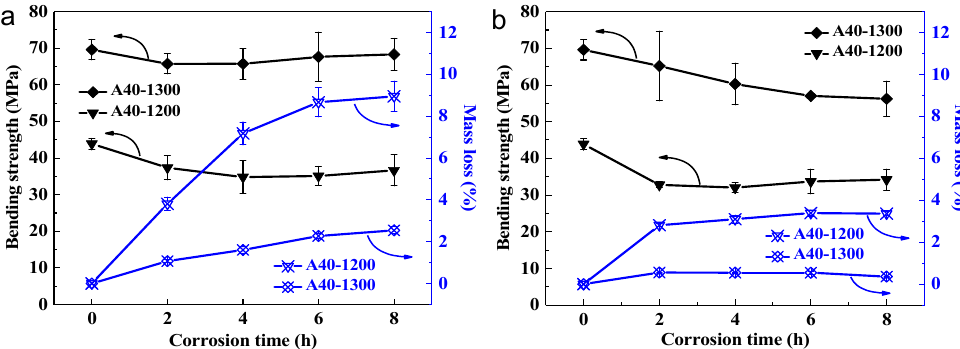
Figure 9. Bending strengths and mass loss rates of A40 samples sintered at 1200 and 1300 °C, before and after corrosion in 10 wt% NaOH ( a ) and 20 wt% H 2 SO 4 ( b ) solutions at 100 °C.